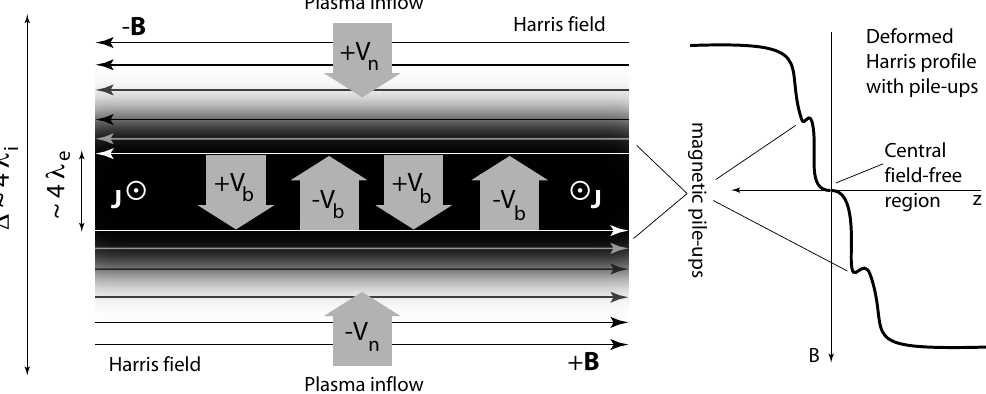
Fig. 1. Sketch of a homogeneous collisionless current sheet with plasma inflow from both sides and central electron inertial region. The central sheet current J is crossed by two (symmetric counter-streaming) electron flows which are unstable against the termal-anisotropic Weibel mode. On the right the magnetically deformed Harris profile is